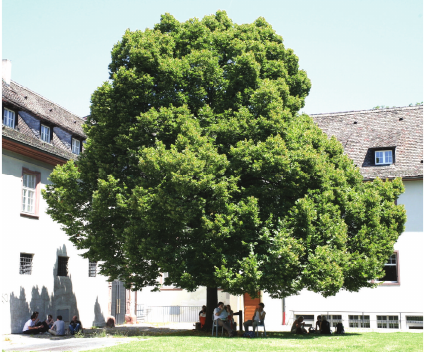
Figure 26: Human thermal comfort below the canopy of a vital lindentreeonatypicalCentralEuropeansummerday(June27,2011) in